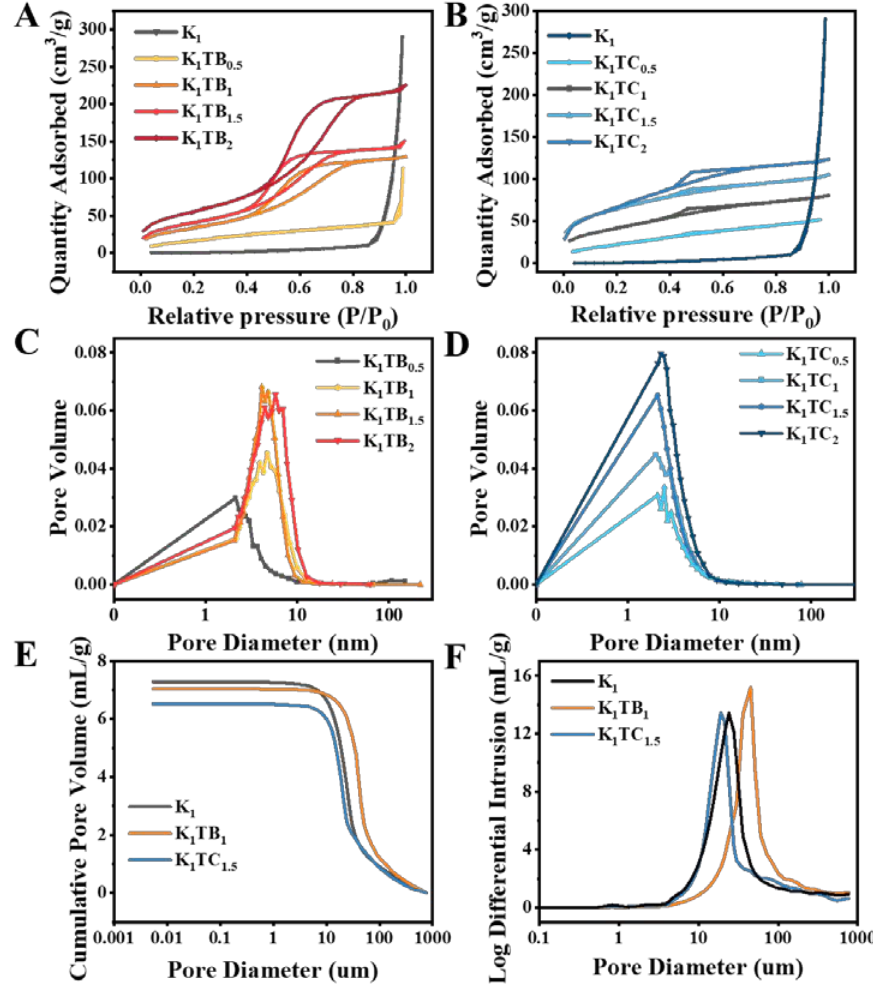
Figure 4. Nitrogen adsorption–desorption curves ( A , B ) and pore size distribution curves ( C , D ) of K 1 , KTB aerogels, and KTC aerogels and cumulative pore volume and log differential intrusion of K 1 , K 1 TB 1 , and K 1 TC 1.5 aerogels ( E , F ) measured by mercury injection method.